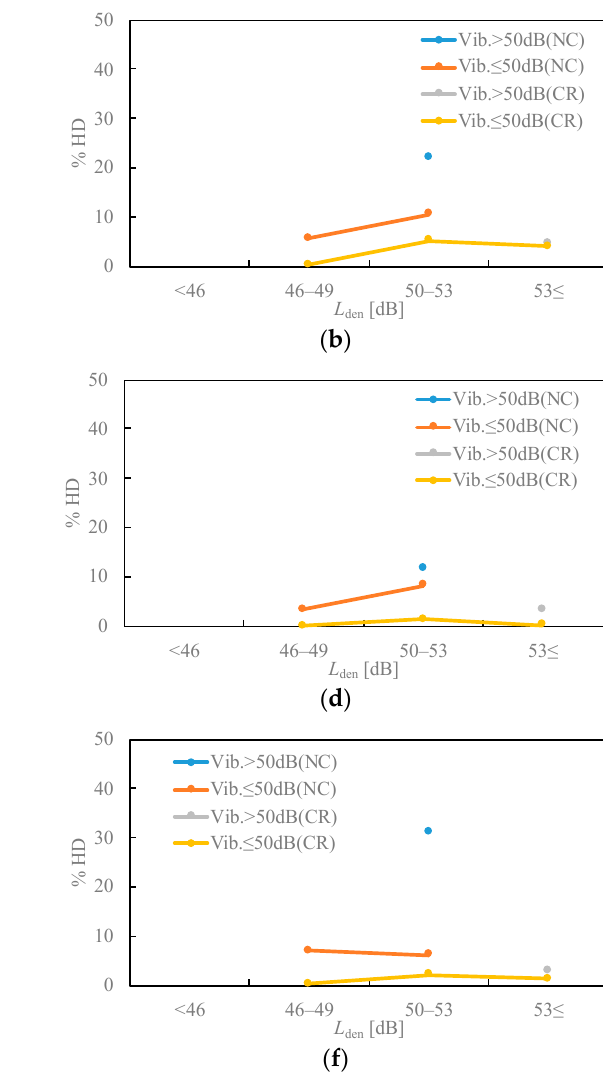
Figure 5. Relationships between noise exposure level and activity disturbance. ( a ) Conversation; ( b ) TV/radio listening; ( c ) reading; ( d ) thinking; ( e ) window open; ( f ) rattling. Table 4. Multiple logistic regression analysis of high noise annoyance by L ASmax , L Vmax and existence of conventional railway (AUC =